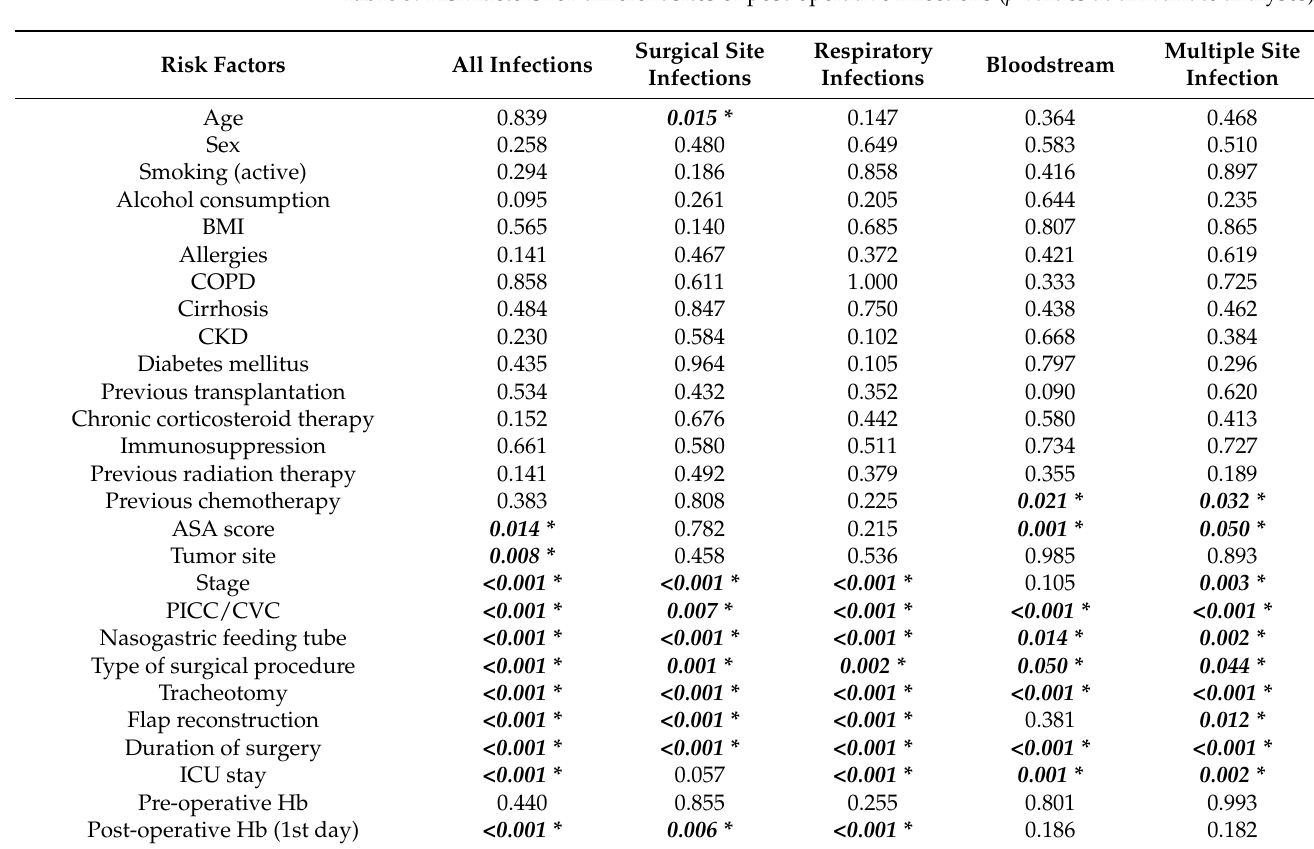
Table 5. Risk factors for different sites of post-operative infections ( p values at univariate